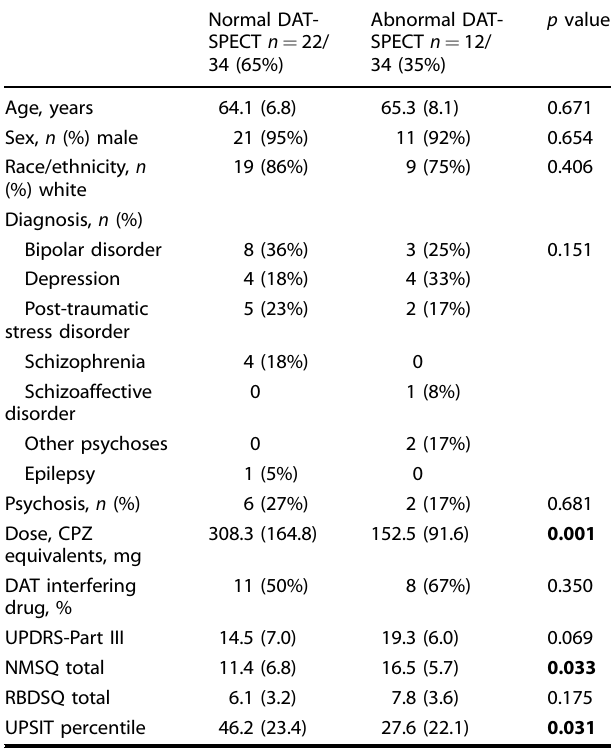
Table 1. Demographic and clinical characteristics of DIP patients with normal and abnormal DAT ‐ SPECT.